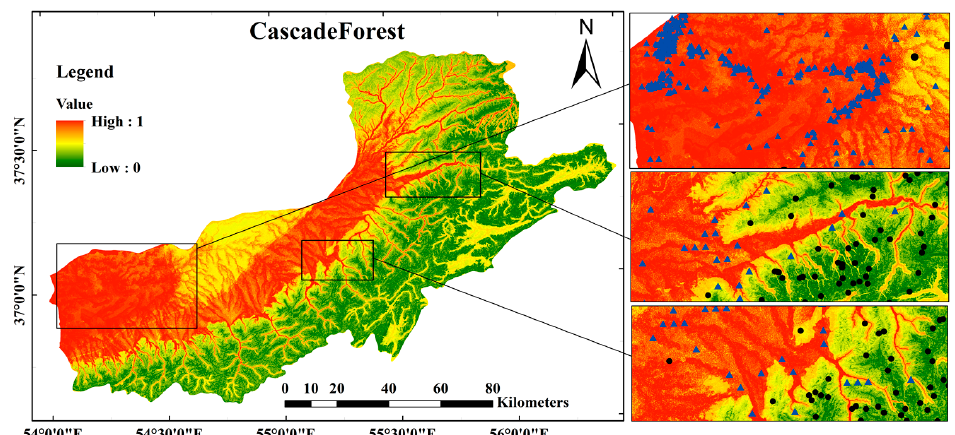
Figure 15. Examples of highly susceptible areas in the Gorganrud basin.